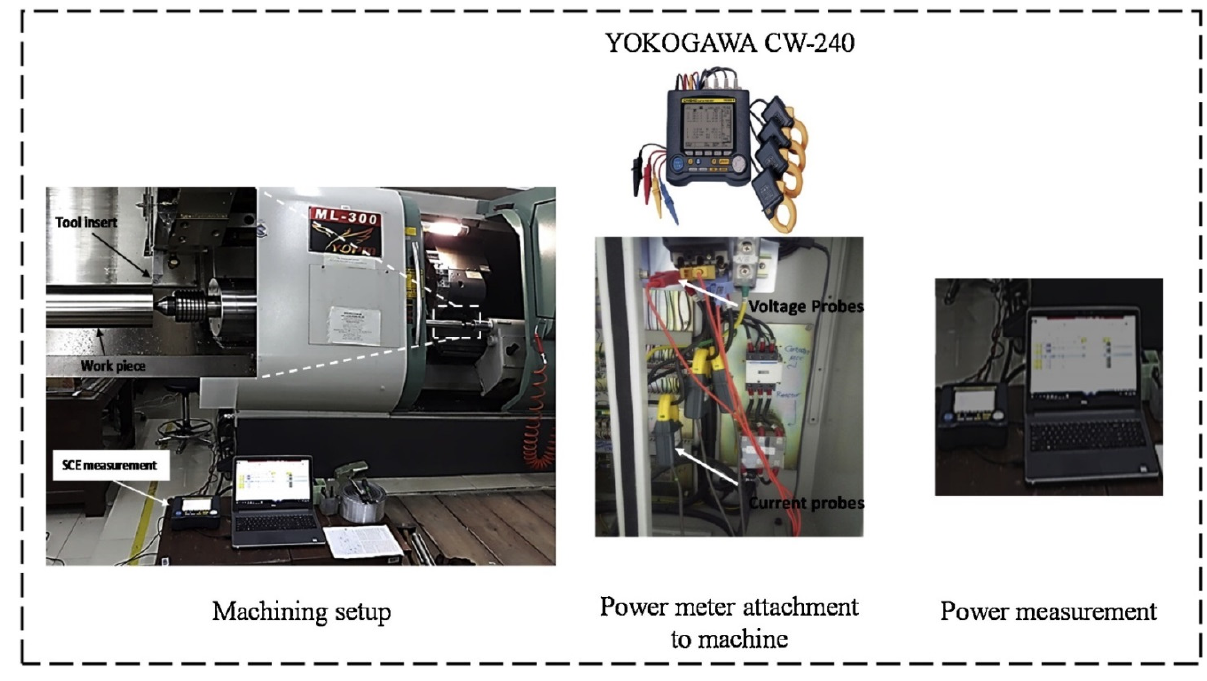
Figure 3. Experimental setups for measurement of cutting power [79].